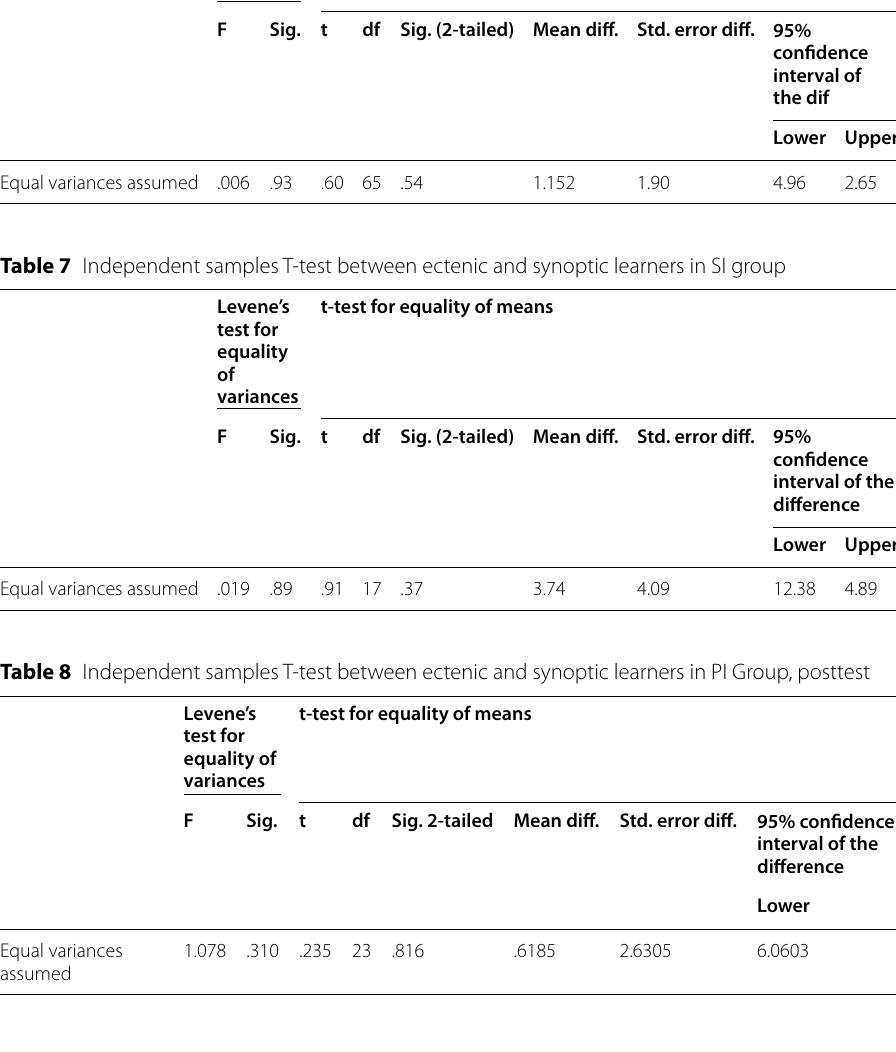
Levene’s t-test for equality of means test for equality of variances